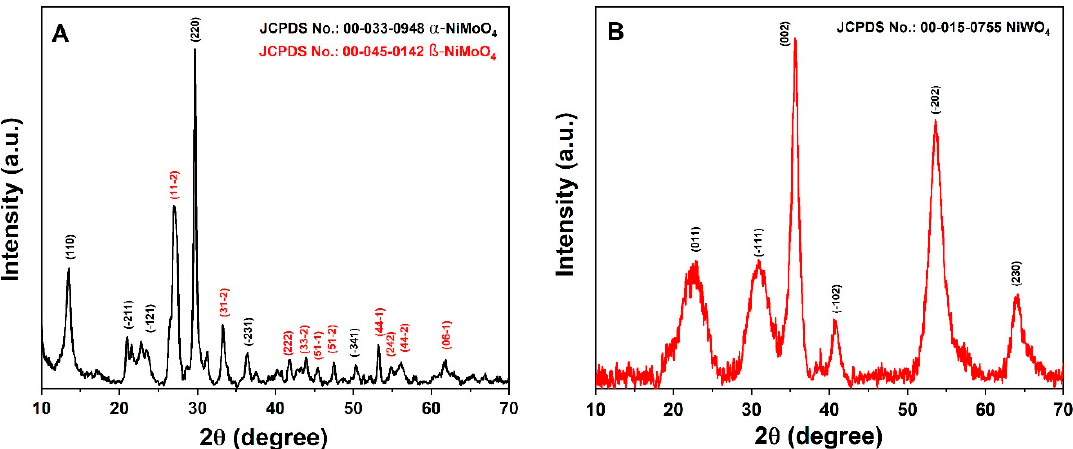
Figure 2. X-ray diffraction patterns of hydrothermally synthesized ( A ) α - and β -NiMoO 4 , and ( B ) NiWO 4 as indicated in the figure.